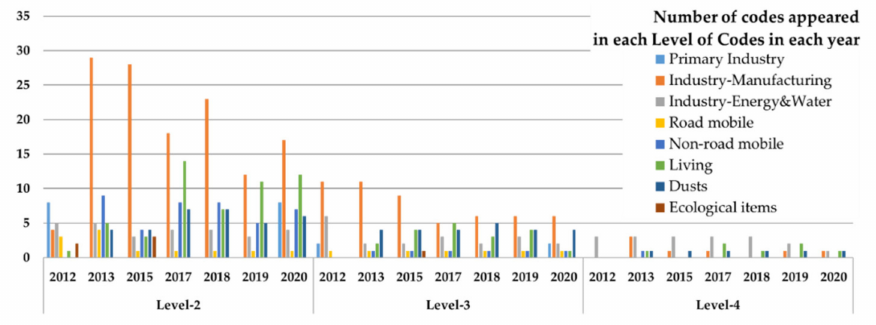
Figure 8. Evaluation of policy contents by the number of codes appearing in each year.